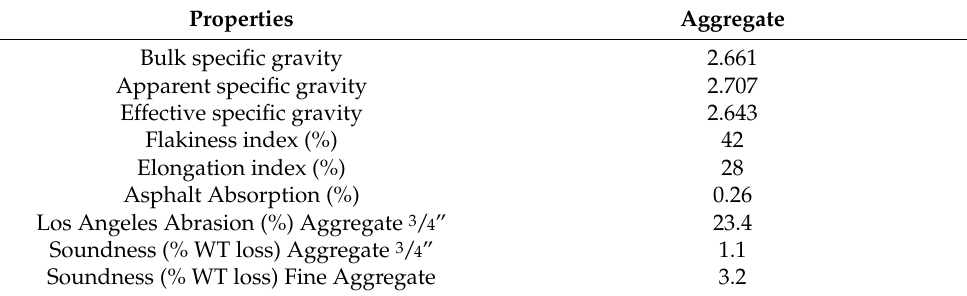
Table 1. Properties of